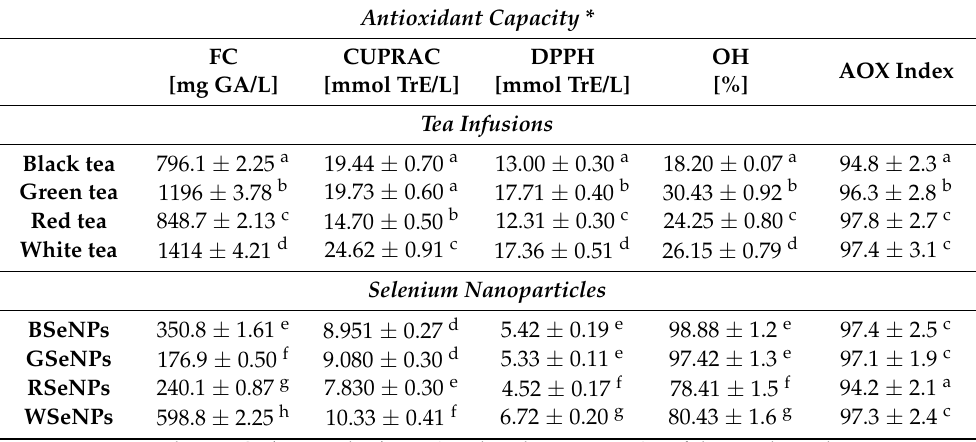
Table 2. Antioxidant activity of tea infusions and selenium nanoparticles. Abbreviations: BSeNPs— nanoparticles synthesized using black tea infusions, GSeNPs—green tea, RSeNPs—red tea and WSeNPs—white tea